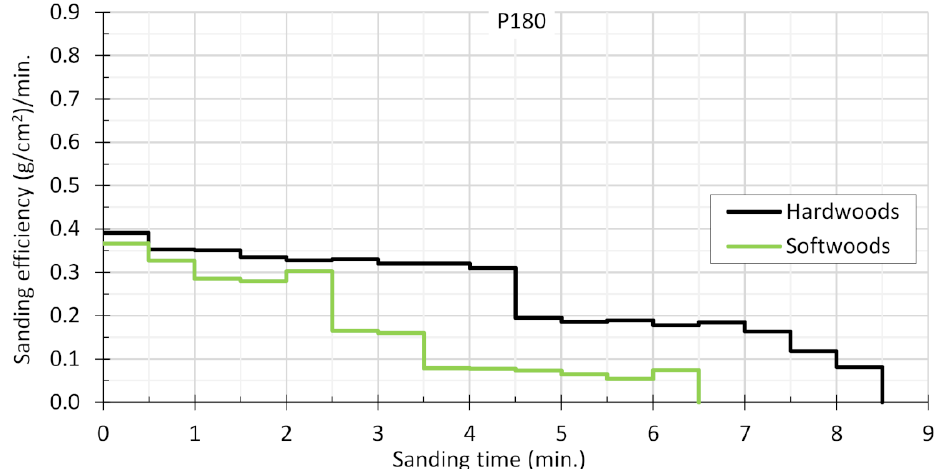
Figure 5. Mean sanding efficiencies of belts with grade